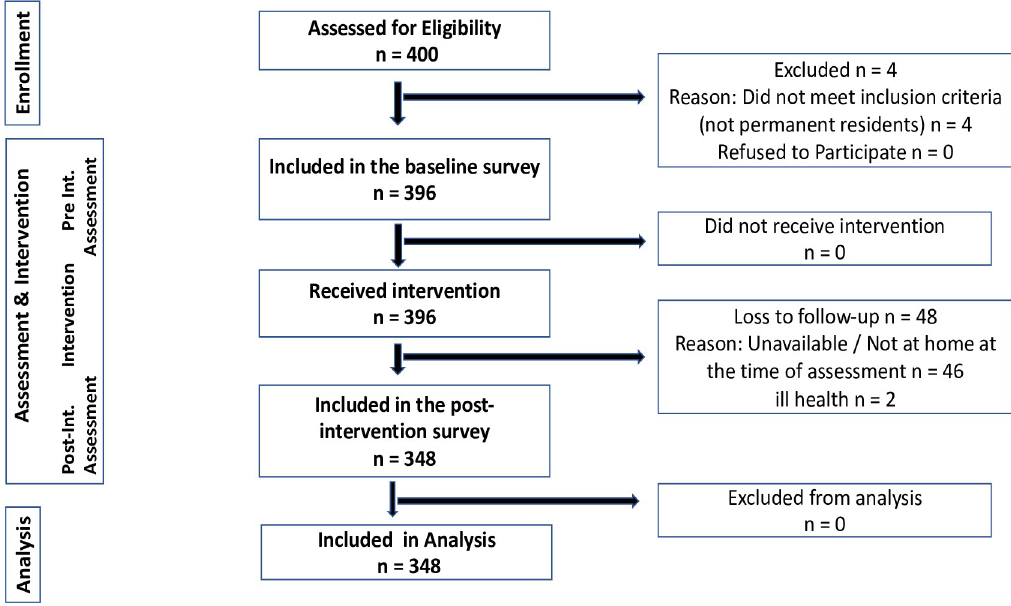
Fig 1. Flow chart of the sampling and recruitment of the study